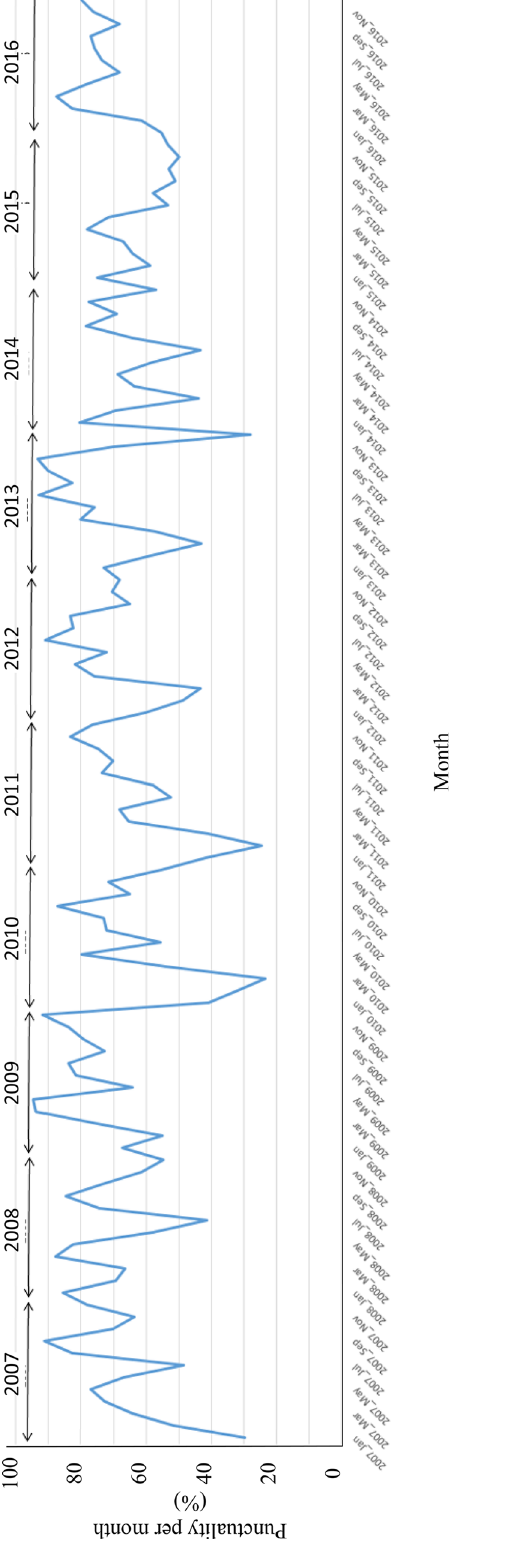
Fig. 6 Number of days (%) with temperature below - 15 (cid:3) C in a month across the Nordland railway network from 2007 to